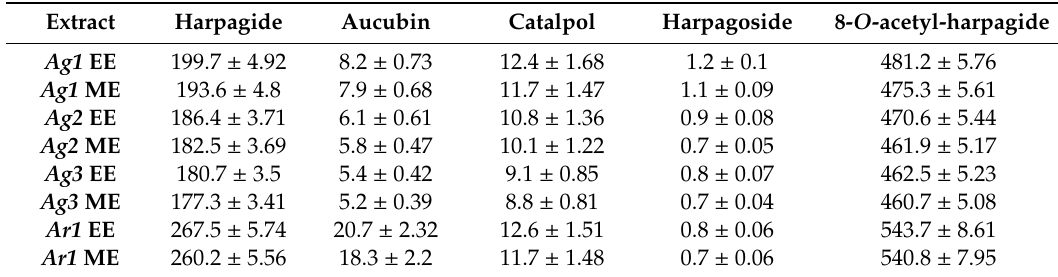
Table 4. The quantification of iridoids in in A. genevensis ( Ag1, Ag2, Ag3 ) and A. reptans ( Ar1, Ar2, Ar3 ) extracts ( µ g / mL